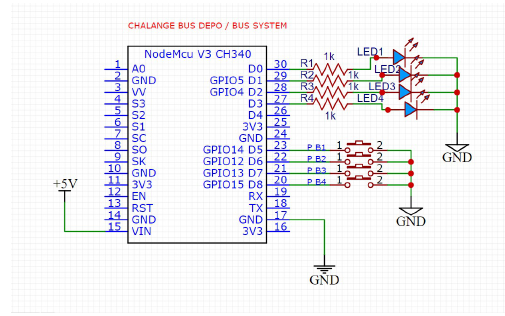
Figure 2. Block Diagram of System Created for Bus Stop